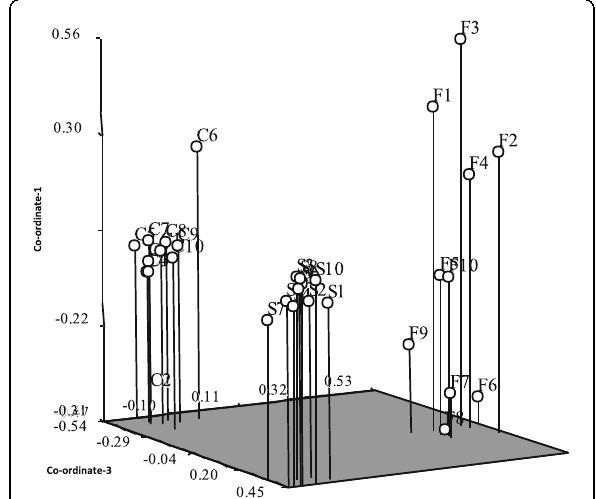
Fig. 7 Three-dimensional representation using PCoA for genetic relatedness among the growth forms of Dendrocalamus